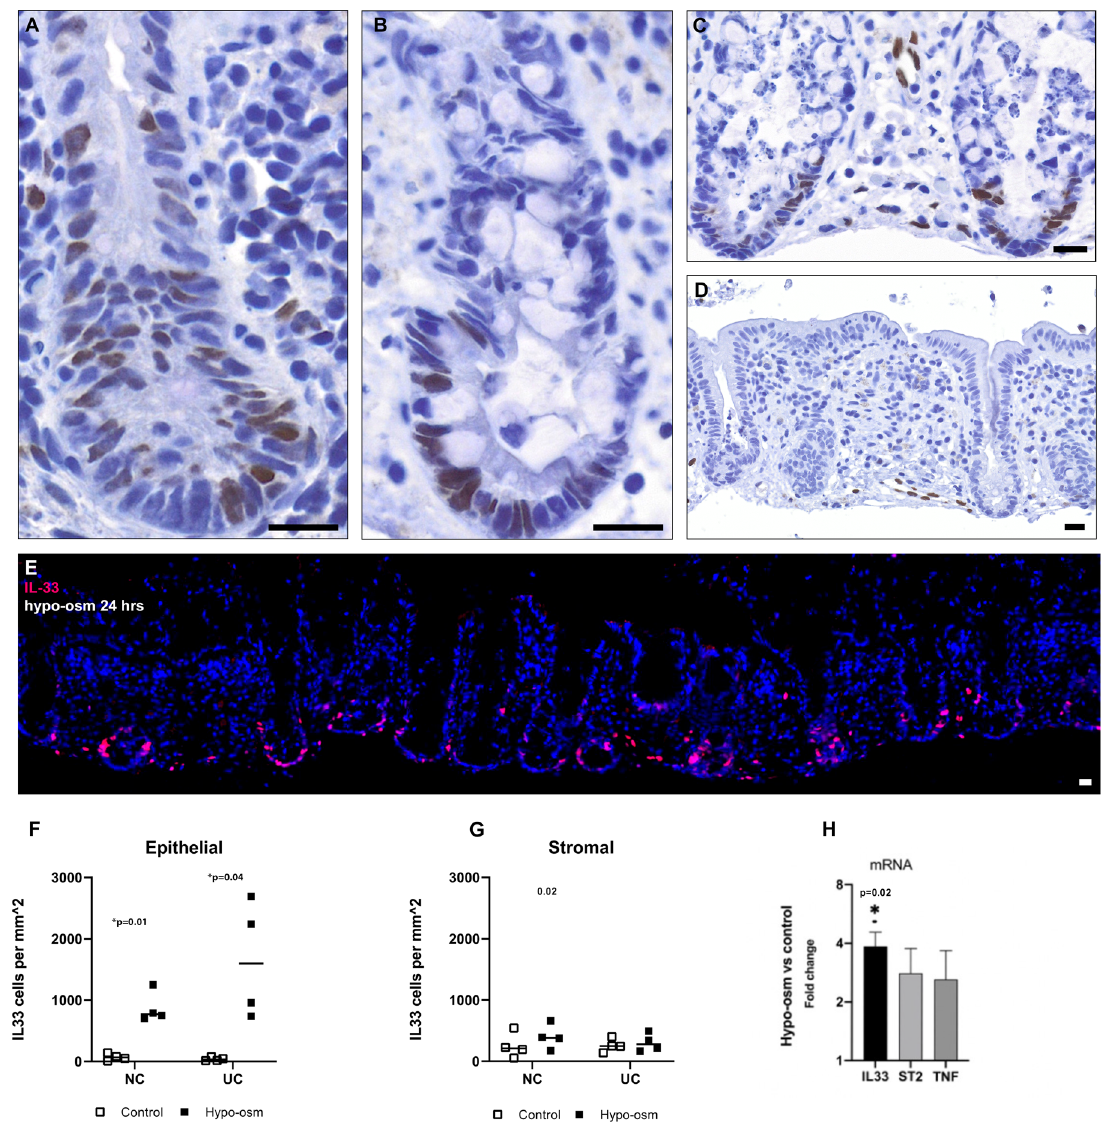
Figure 3. Hypo-osmotic stress induces IL-33 in colonic crypts . Colonic biopsies from ex vivo biopsy cultures including quiescent UC with a a Mayo score ≤ 2 (image A,E ) and healthy controls (image B–D ). Stimulation with hypo-osmotic medium for 24 h induces positive IL-33 (brown) cells shown with immunoenzymatic staining in ( A–C ). Cell nuclei stained with hematoxylin (blue). Control biopsy cultured for 24 h in basal medium (image D) did not show IL-33 positive cells in the epithelium. Image ( E ) shows fluorescence staining in UC after 24 h of hypo-osmotic basal medium, IL-33 (red) is seen in the nucleus of epithelial cells with cell nuclei counterstained with Hoechst (blue). IL-33 was significantly increased in the epithelium of both healthy controls (NC) with a p-value = 0.01 and for UC p-value = 0.04 following hypo-osmotic exposure for 24 h (graph F ). No significant changes were seen in the stroma (graph G ) p-values 0.14 and 0.38 for NC and UC. Graph ( H ) shows fold change of mucosal gene expression for IL33, ST2 and TNF comparing biopsies stimulated with hypo- osmotic medium or basal medium (controls) for 24 h. Scale bars = 20